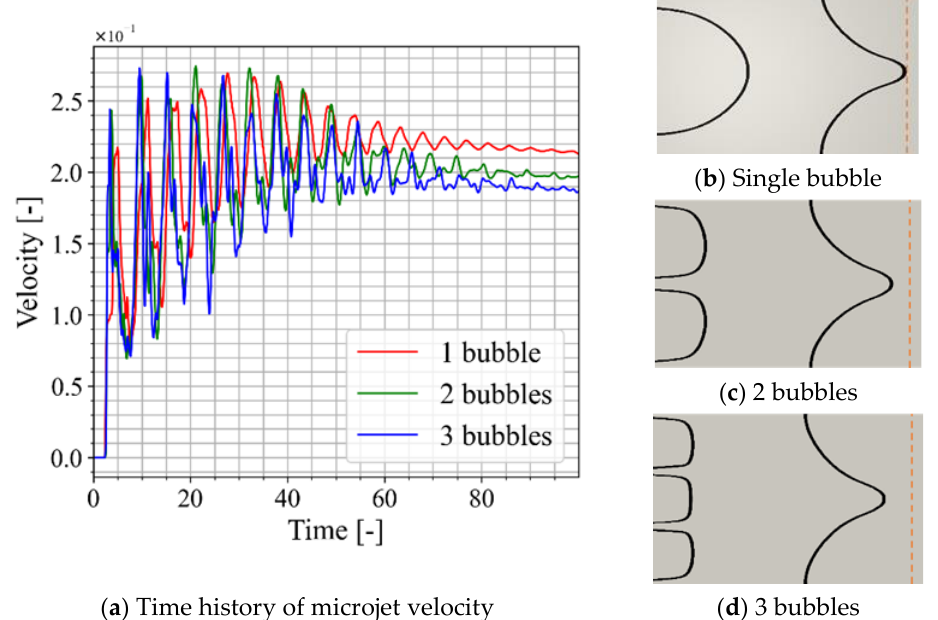
Figure 5. Time history of microjet velocity and microjet formations at the final state. The orange dashed line in ( b ) – ( d ) shows the position of the microjet head in the single bubble case. Interfaces are shown by the density gradient.